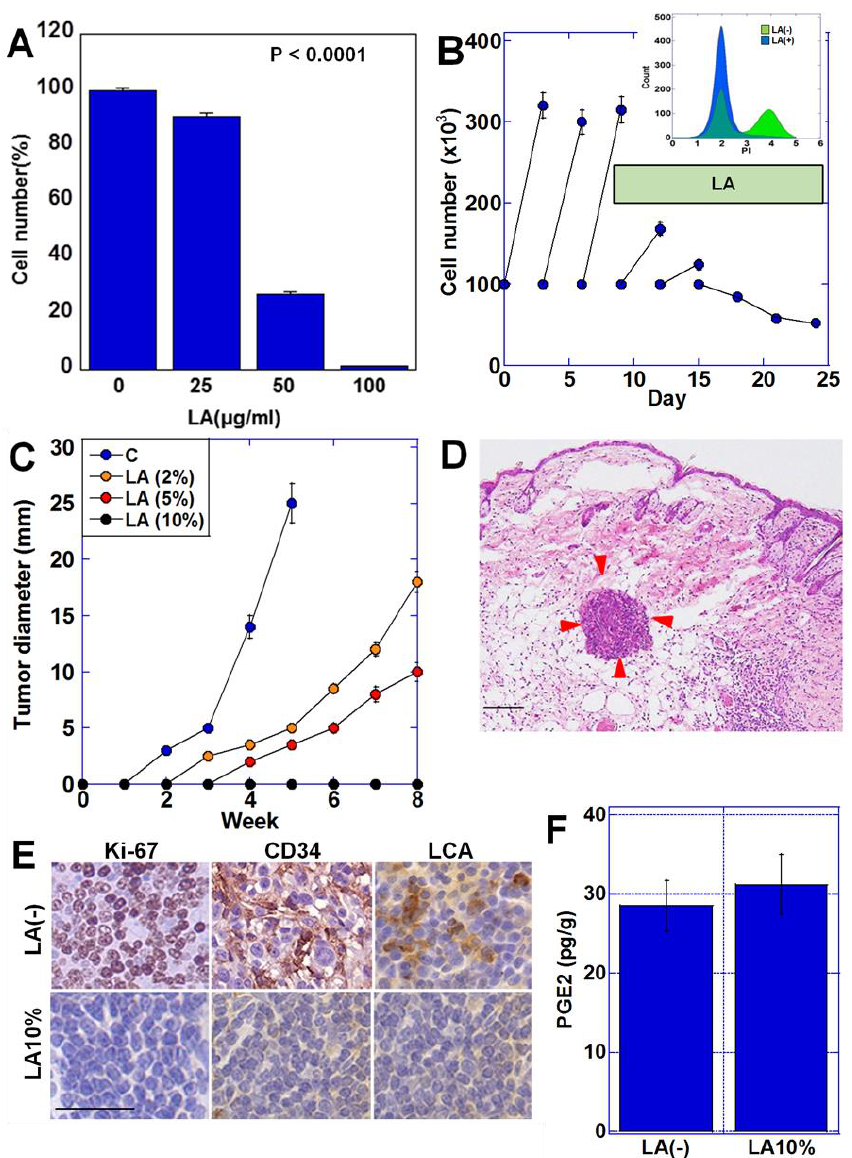
Figure 1. LA induced dormancy in CT26 cells. ( A ) Effect of short-term LA treatment on cell prolif- eration. ( B ) Effect of continuous LA treatment up to 25 days. (Insert) Cell cycle analysis of CT26 cells with or without continuous LA treatment. ( C ) Effect of LA on the growth of CT26-derived subcutaneous tumors in mice. Mice were fed a CE-2 standard diet containing LA (C, standard diet; 2%, 5%, and 10%, standard diet with LA (% w / w )). ( D ) Subcutaneous CT26 cell aggregation (red arrow). Hematoxylin and eosin staining. ( E ) Immunohistochemical analysis of proliferation (Ki-67), angiogenesis (CD34), and immune cell infiltration (LCA) of CT26 tumors in 10% LA-fed or standard diet-fed mice. ( F ) PGE2 concentration in CT26 tumors in 10% LA-fed or standard diet-fed mice. Scale bar, 100 µ m. Error bar, standard deviation based on three independent trials. LA, linoleic acid; HPF, high-power field of view; LCA, lymphocyte common antigen; PGE2, prostaglandin